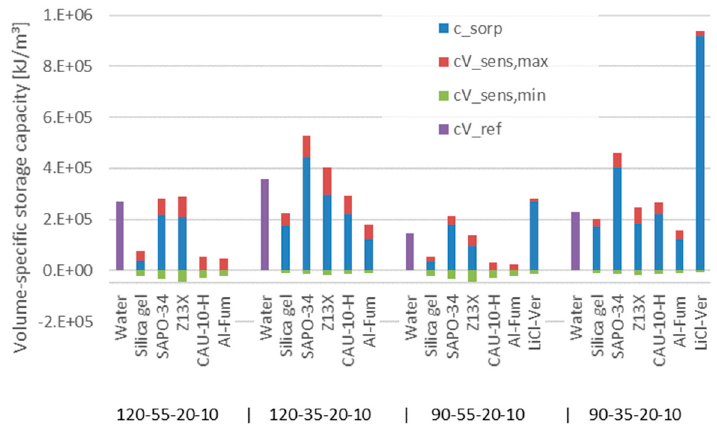
Figure 8. Volumetric storage capacity of the selected materials for two different de- and adsorption temperatures (specified below material names in the following order; T des -T ads -T cond -T evap ).